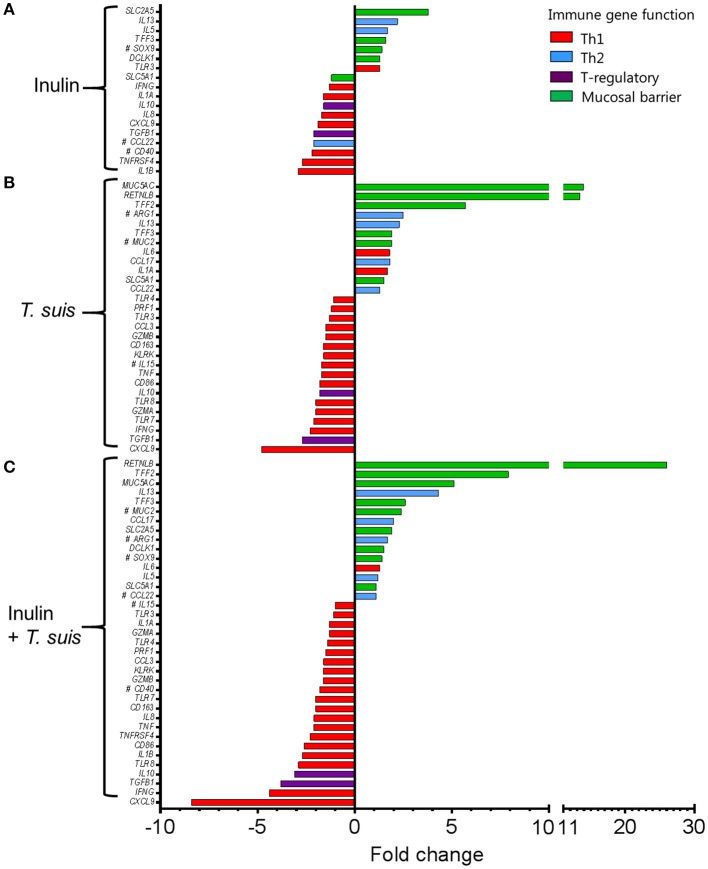
Intestinal gene expression is significantly altered by diet and/or helminth infection. Shown is the expression of all statistically significant genes (p ≤ 0.05) compared to control pigs fed a basal diet and without Trichuris suis infection. (A) Expression of diet-influenced genes in inulin-fed pigs without infection. (B) Expression of infection-influenced genes in T. suis-infected pigs fed a basal diet. (C) Expression of diet or infection-influenced genes in pigs fed inulin and infected with T. suis. #p < 0.1, indicates a trend toward statistical significance, determined by mixed model.